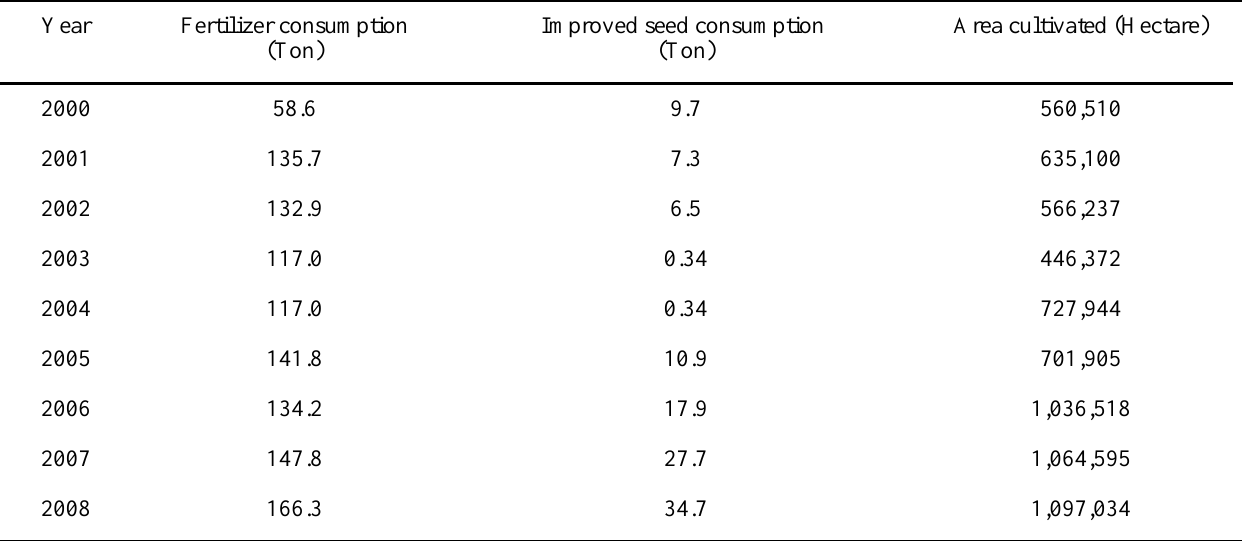
Table 2 . Distribution of agricultural inputs and area cultivated, 2000-2008